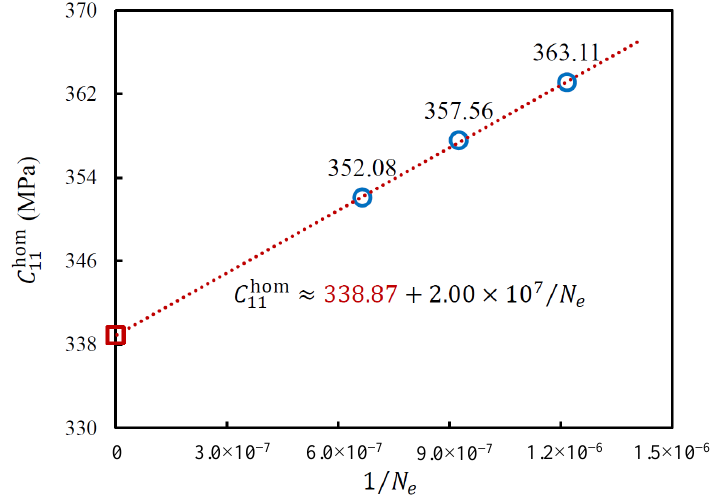
Figure 8. The relation between C hom